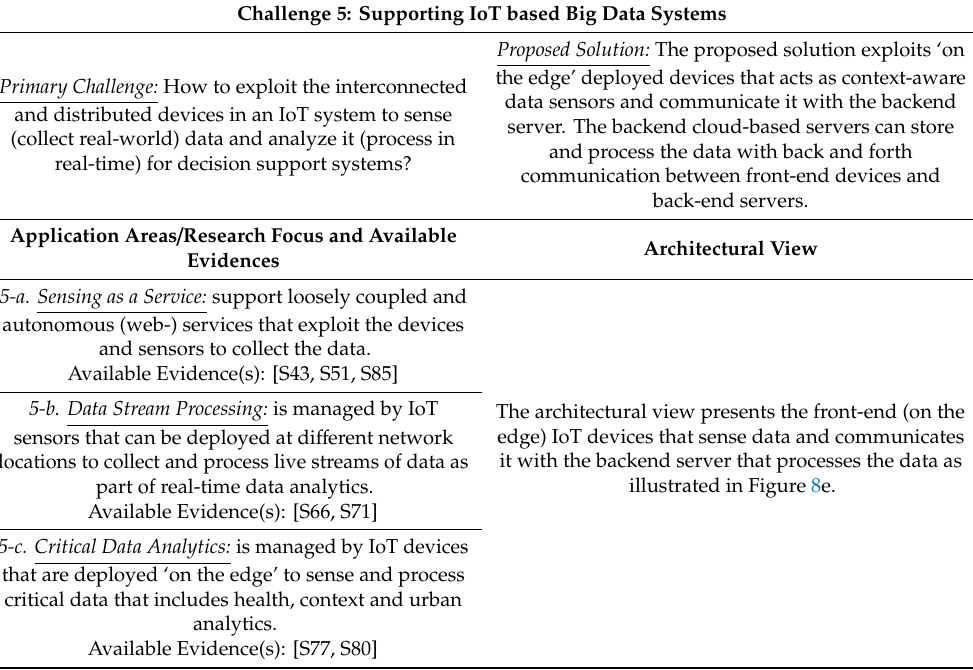
Table 9. Challenge V— Overview of the challenges and architectural solutions for supporting Iot based big data systems.